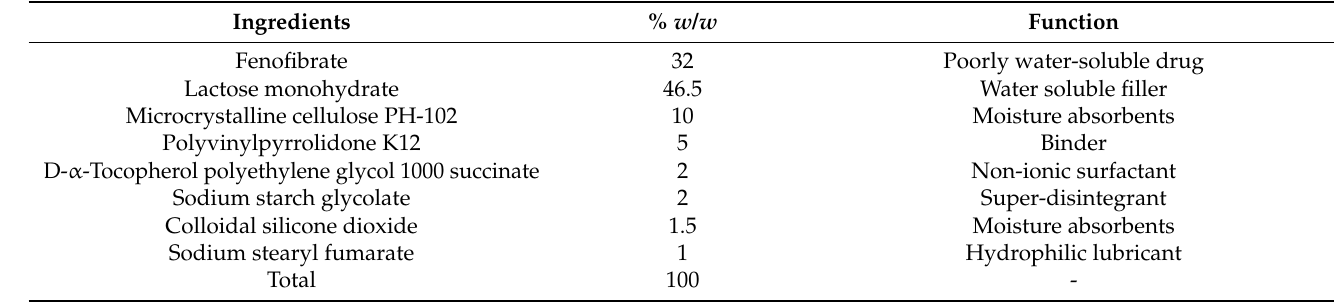
Table 3. Formulation used in the granulation